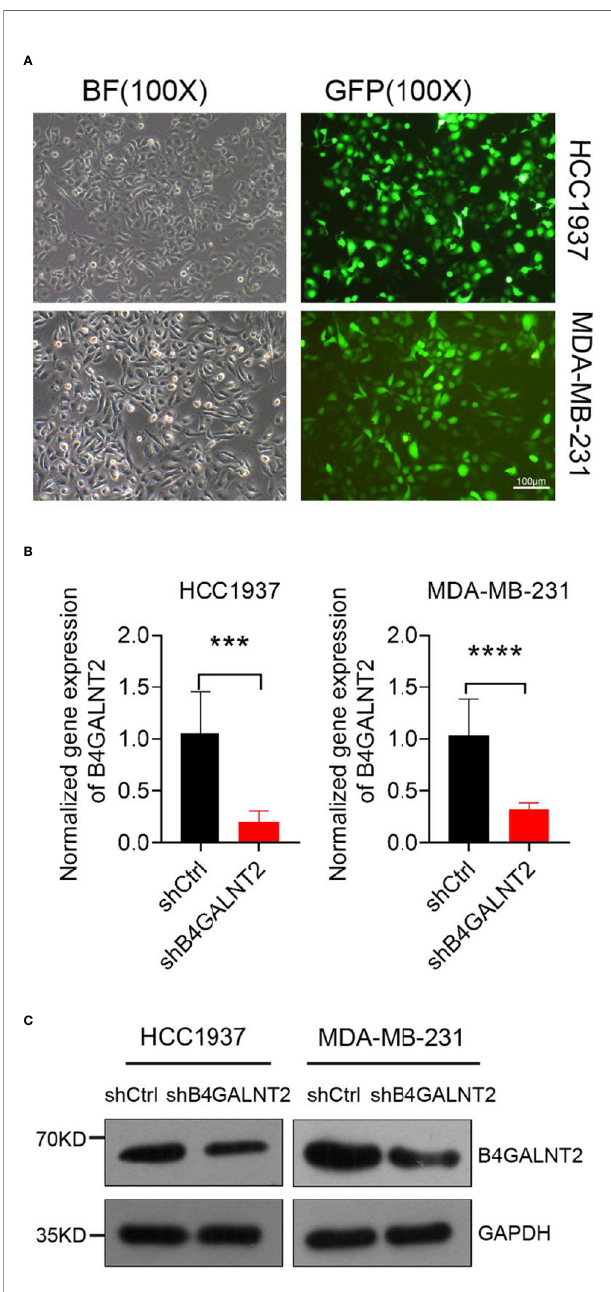
FIGURE 2 | Construction of the cell model. (A) Lentiviral transfection ef fi ciency of two breast cancer cell lines. (B, C) The mRNA and protein expression levels of B4GALNT2 gene were detected by RT-qPCR and Western blot after 72h of transfection with lentivirus. The success of the model construction is re fl ected in the joint results of (B, C) . ***p < 0.001, ****p <